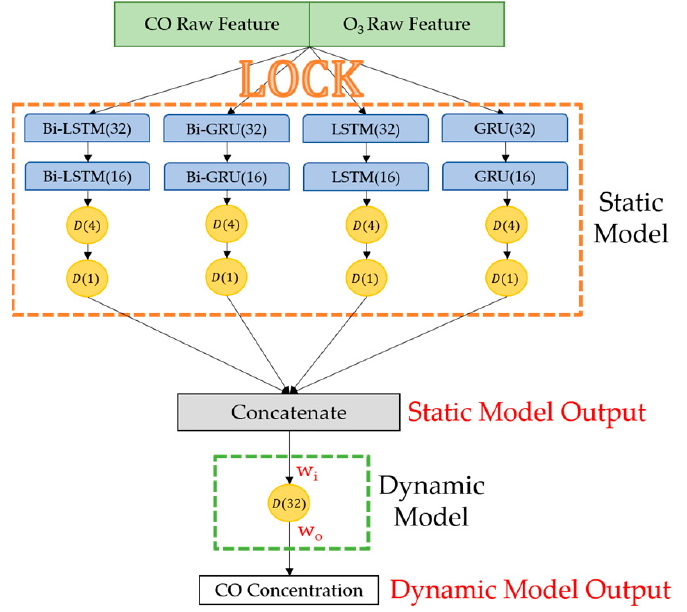
Figure 13. An example of schematic diagrams of gas ensemble model: CO gas ensemble model. Weight coefficients w i and w o change periodically through the further model retraining procedure.